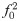
(a) Plot of normalized variance var(U)/A2 for U = A cos(θ) as a function of θ for a single ring network and various κ. In the spontaneous case (κ = 0) the variance is uniformly distributed around the ring (ignoring transients). The presence of a stimulus (κ > 0) suppresses the overall level of noise and the variance exhibits a bimodal tuning curve. (b) Plot of variance in firing rates var(f(U) (in units of f02) as a function of θ for a single ring network and various κ. f is given by the sigmoid function (2) with γ = 4 and η = 0.5. The corresponding amplitude A ≈ 1.85.